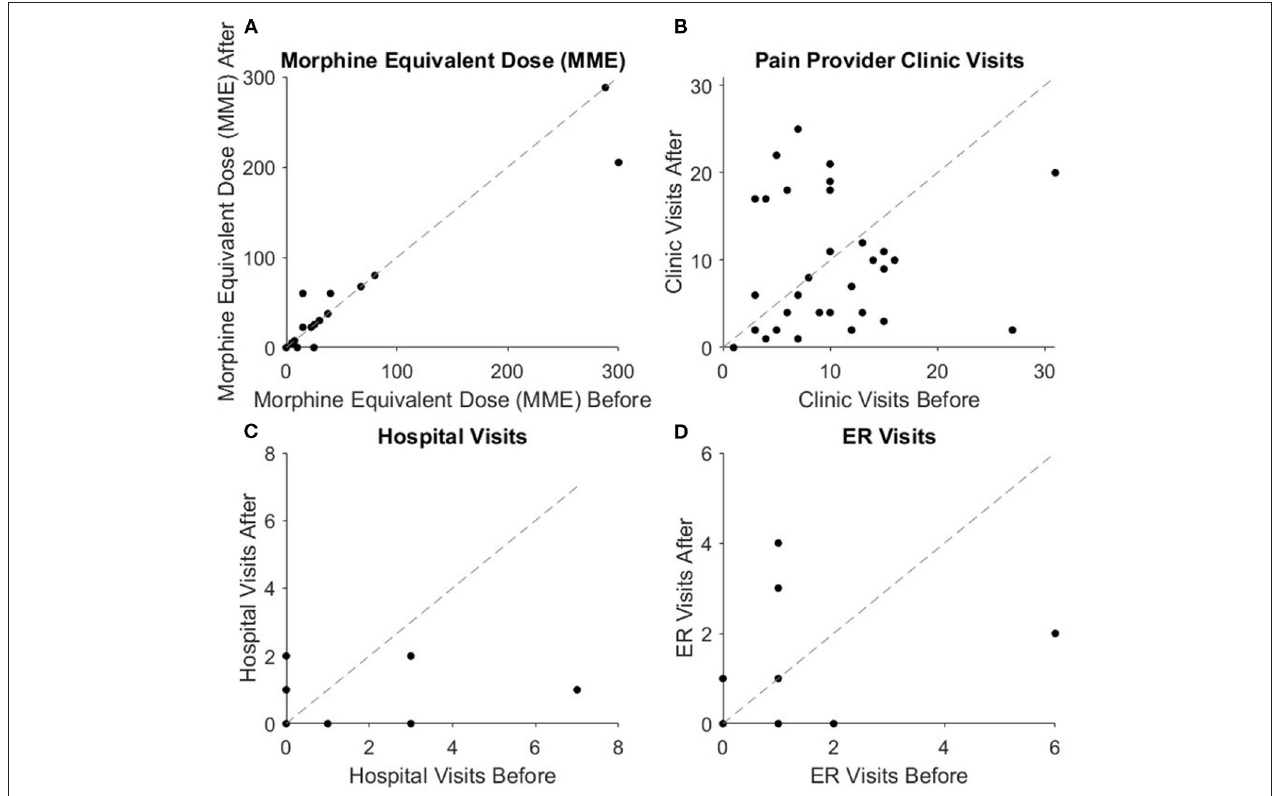
FIGURE 1 | Scatter plots showing qualitative visualization of pain-related data. The dotted line indicates patients who experienced no change with inclusion at multidisciplinary conferences. Data points below and to the right of the line indicate patients with higher (A) MME, (B) clinic visits, (C) hospital visits, and (D) ER visits pre-inclusion than post-inclusion, indicating improvement with inclusion at multidisciplinary